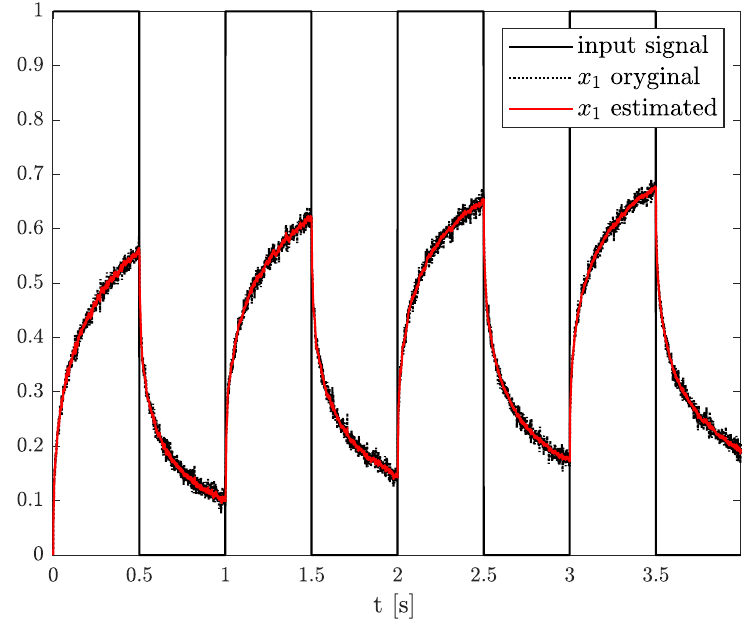
Figure 5. Original and estimated state variables from Example